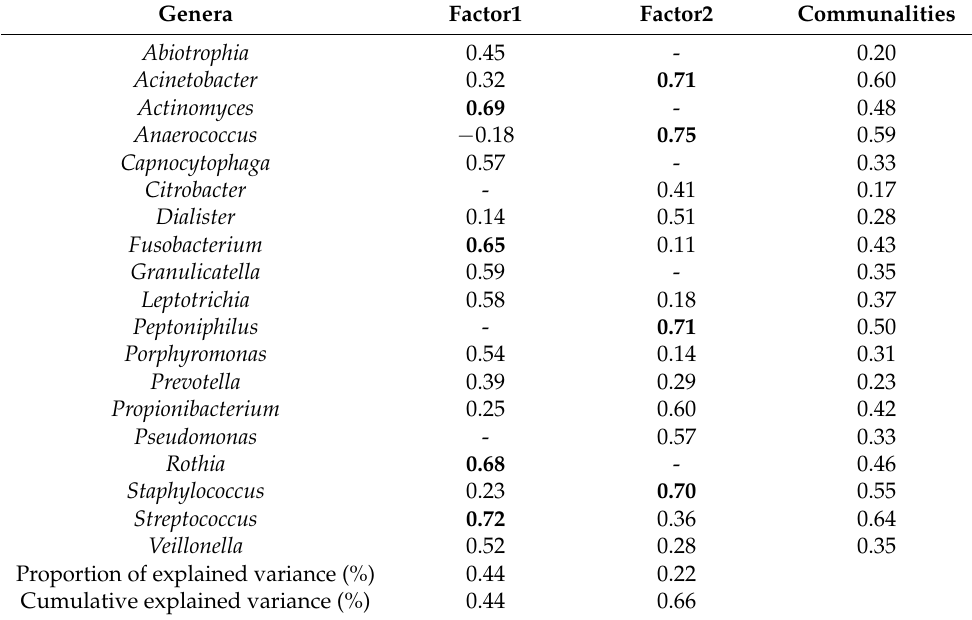
Figure 3. Correlation matrix of the 19 genera used in the factor analysis. Table 5. Factor-loading matrix, communalities, and explained variance for two microbiome patterns identified by factor analysis.